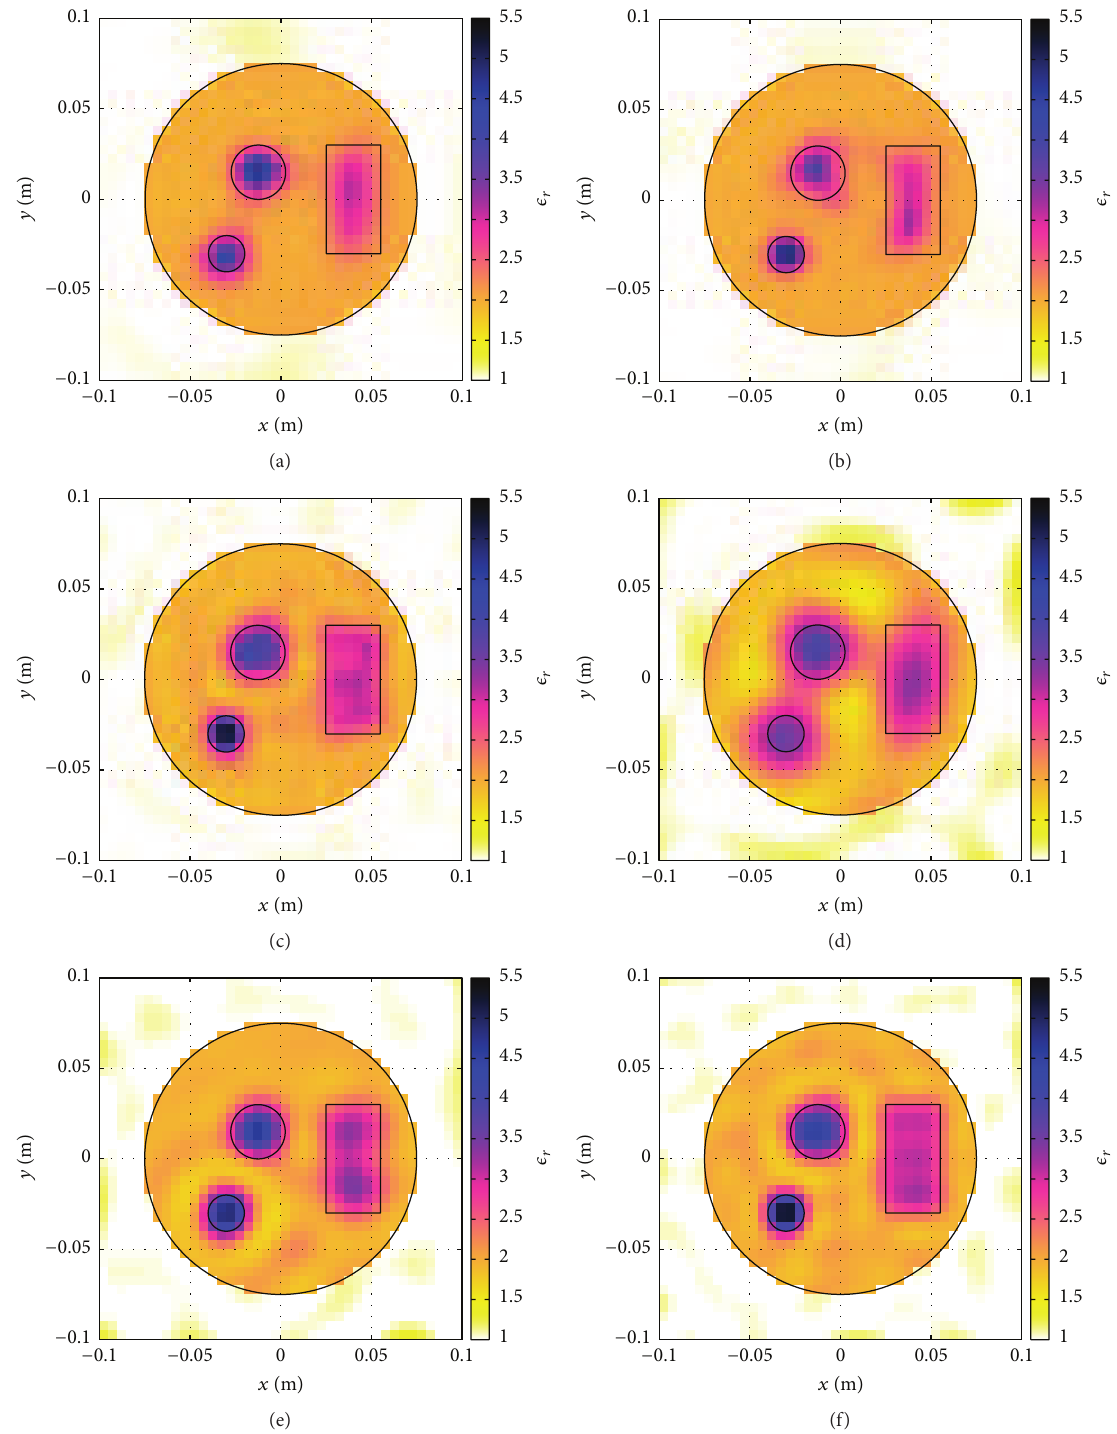
Figure 2: Reconstructed distributions of the relative dielectric permittivity of the investigation domain in different operating conditions, with 𝑆 = 20 and SNR = 20 dB. Banach space reconstructions: (a) 𝐹 = 1 , 𝑝 = 1.3 ; (b) 𝐹 = 2 , 𝑝 = 1.3 ; (c) 𝐹 = 3 , 𝑝 = 1.6 . Hilbert space reconstructions: (d) 𝐹 = 1 , 𝑝 = 2.0 ; (e) 𝐹 = 2 , 𝑝 = 2.0 ; (f) 𝐹 = 3 , 𝑝 = 2.0